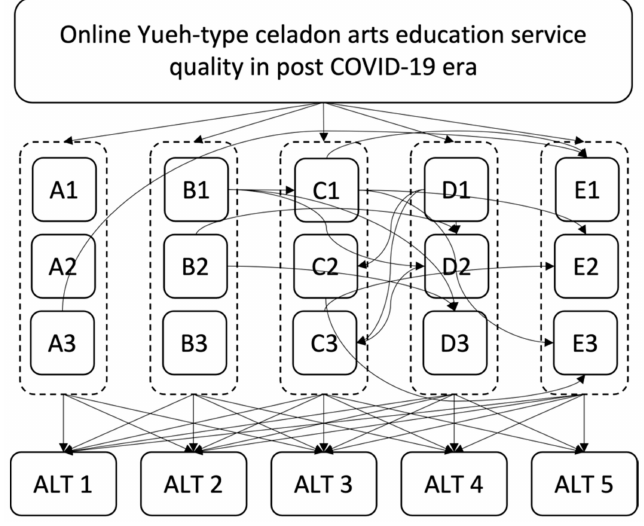
Figure 3. The hierarchy and network structure of this